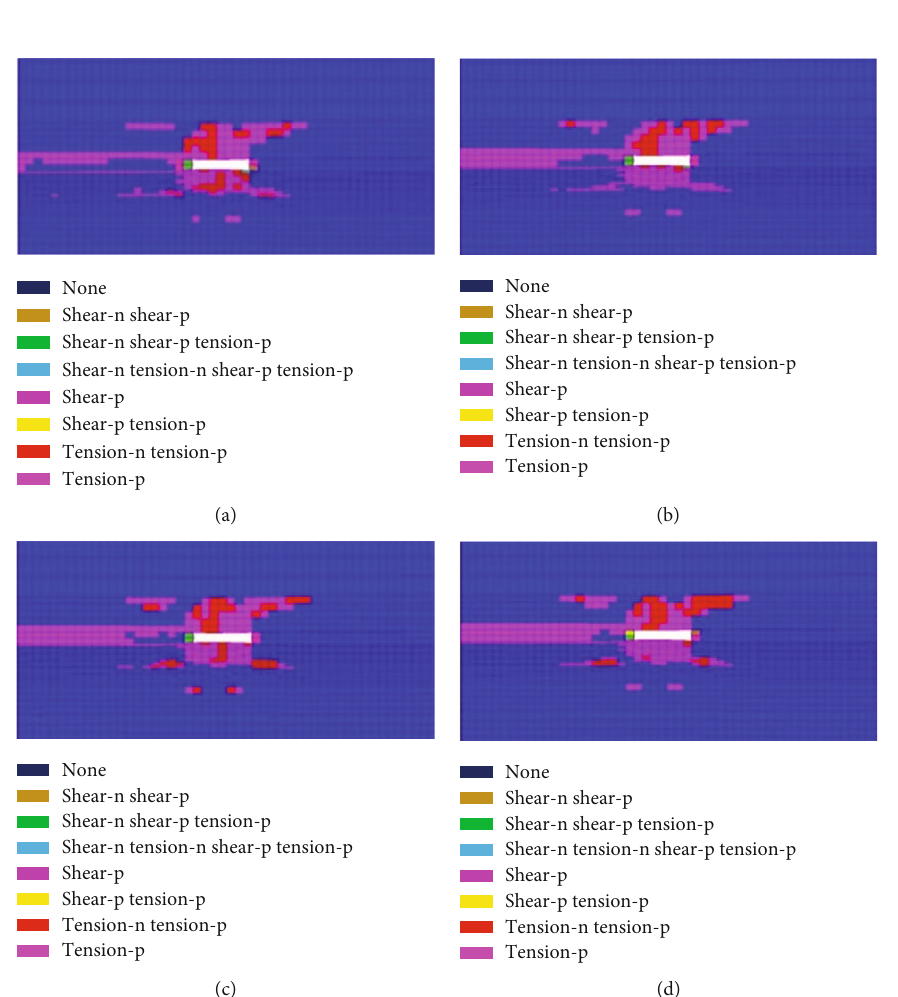
Figure 7: Numerical simulation of the plastic zone of 28 d strength of the di ff erent paste: (a) 3 MPa, (b) 4MPa, (c) 5 MPa, and (d) 7